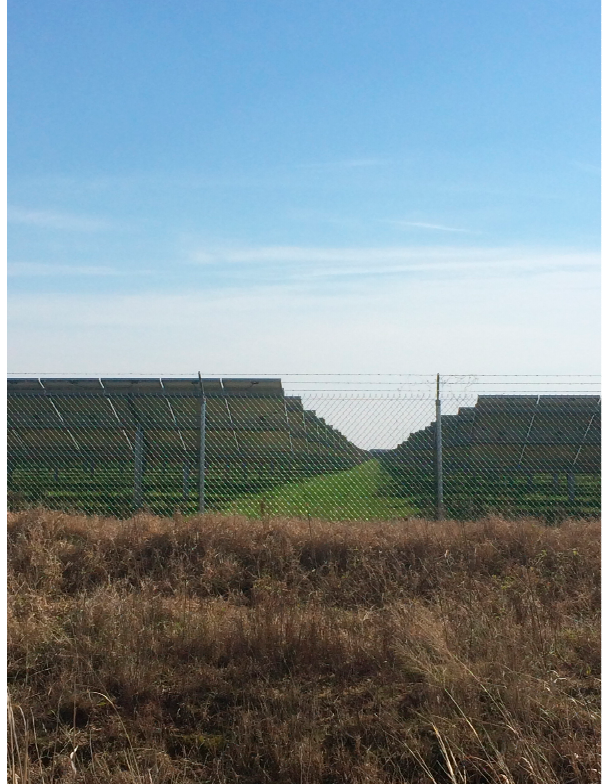
Figure 2. Solar Fields on the former Goodwin-Bauman Farm.